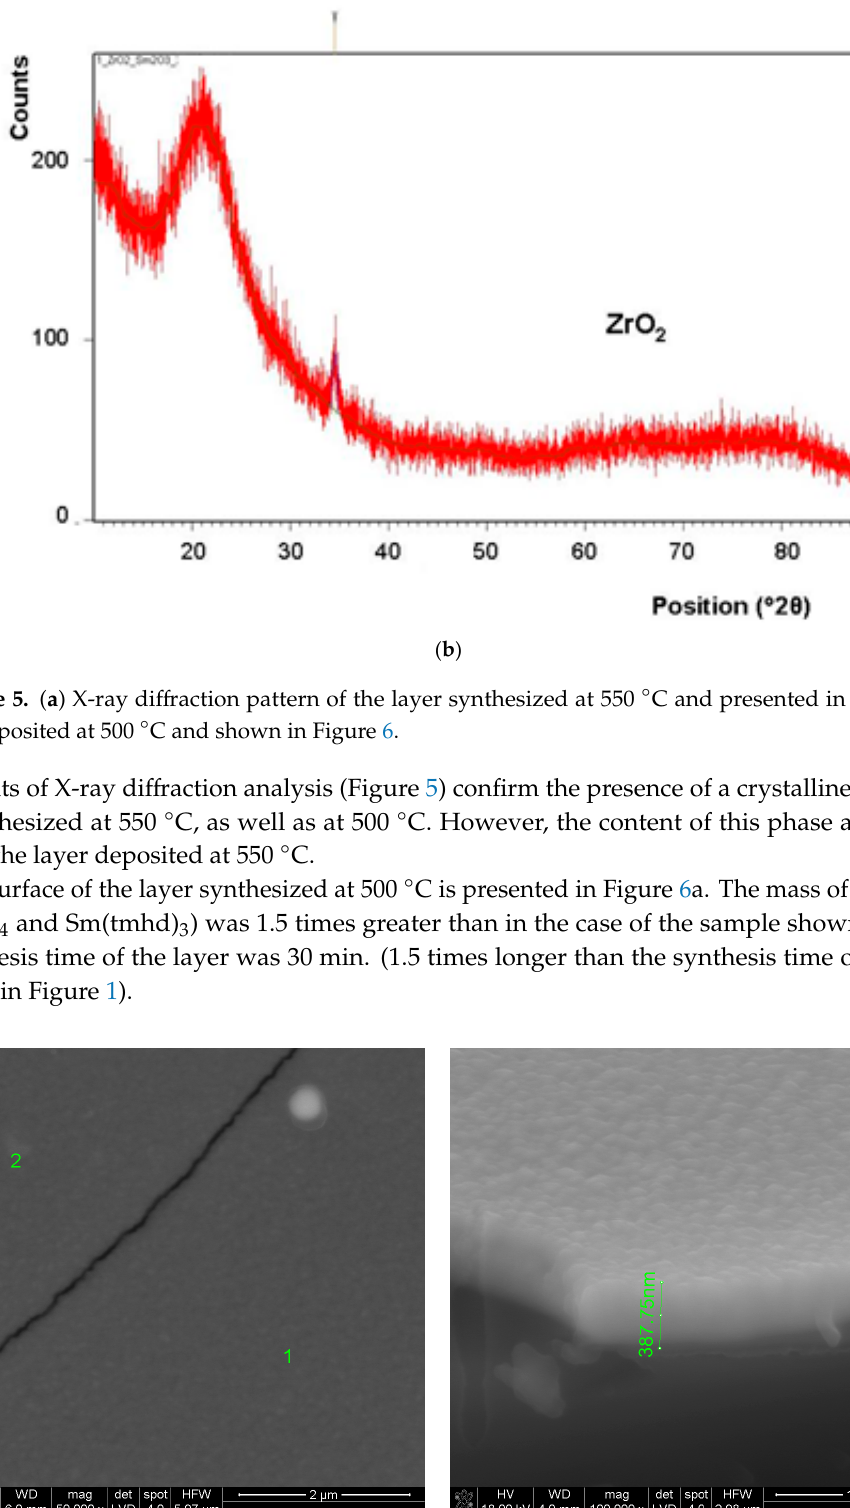
Figure 6. The surface ( a ) and cross-section ( b ) of the layer synthesized at 500 °C. The mass of reactants was 1.5 times greater than in the case of the sample presented in Figure 1. Synthesis time: 30 min. (50%